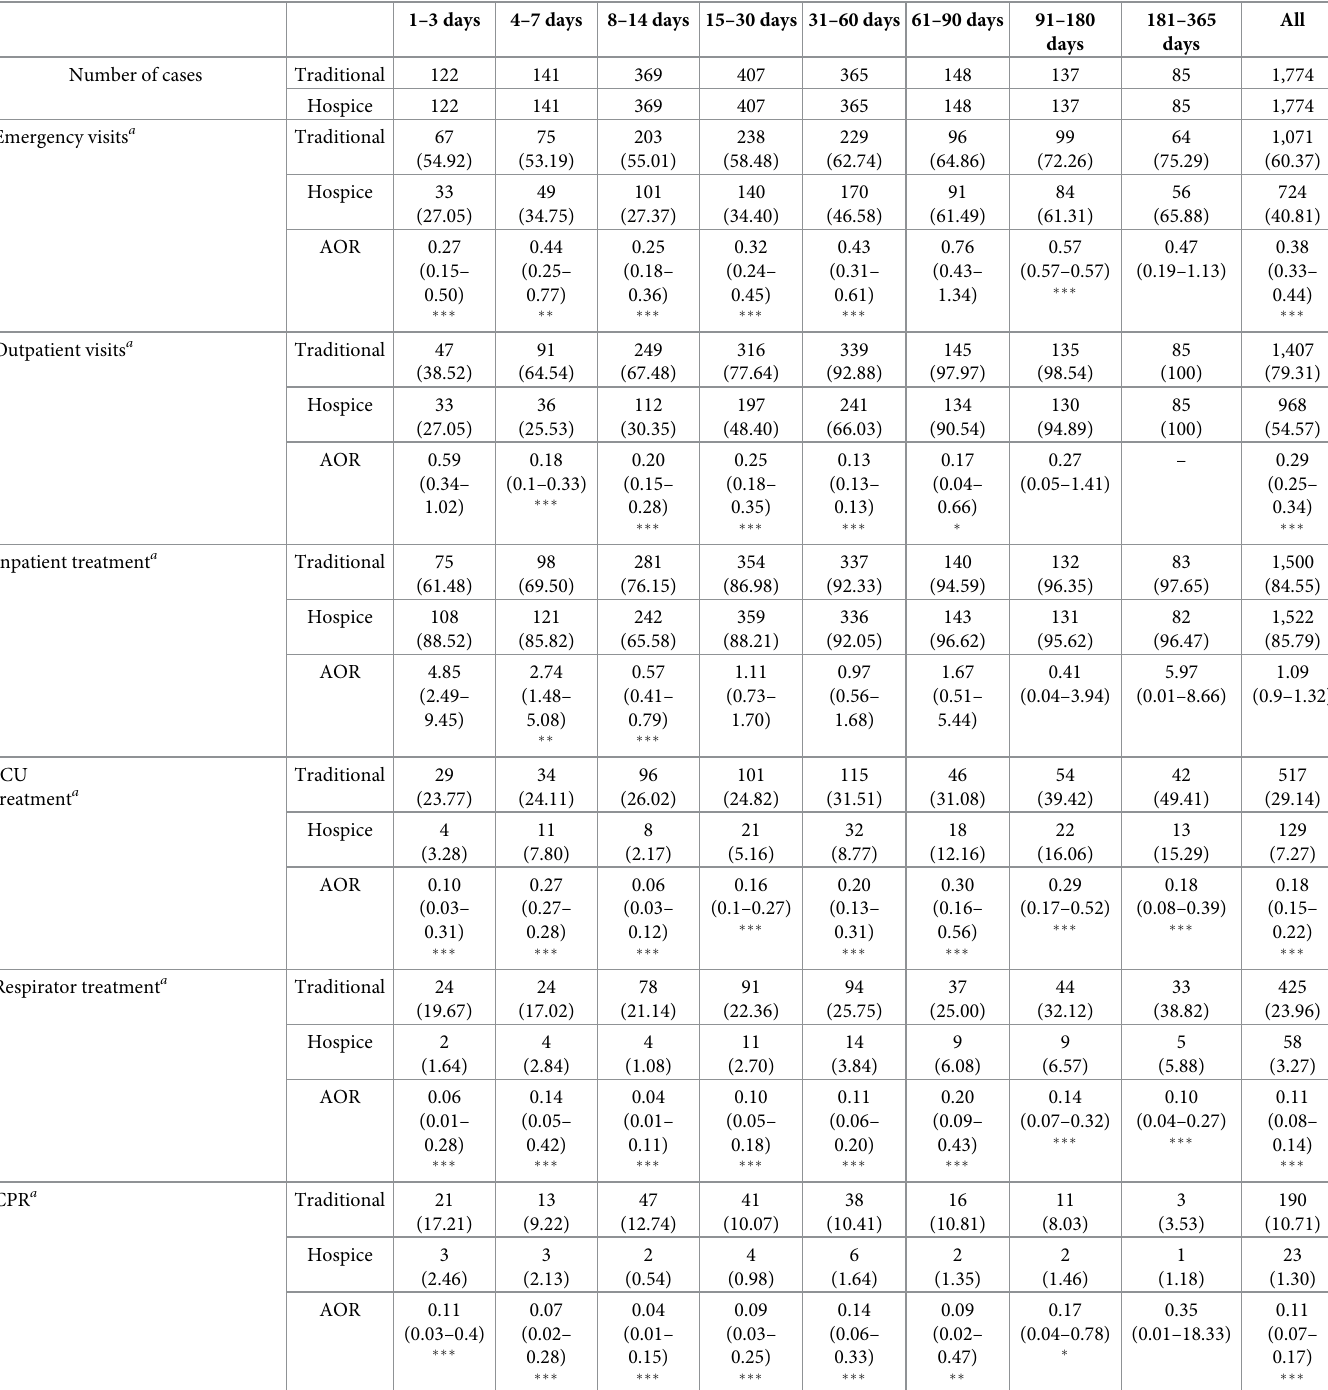
Table 3. Differences in medical treatment behaviors between traditional care and hospice care patients a